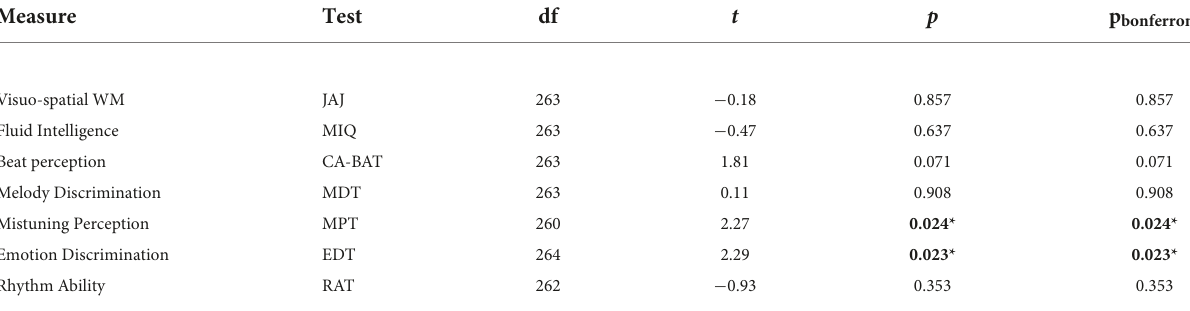
TABLE 7 ANCOVAs results for gender after Bonferroni correction and controlling for general music sophistication. Measure